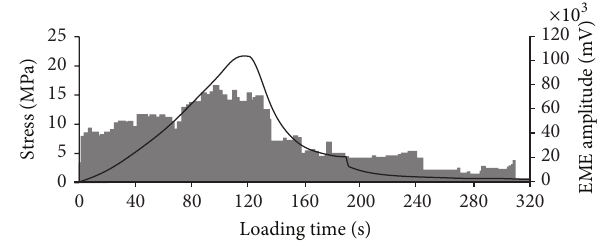
Figure 5: Curves of stress and electromagnetic amplitude.